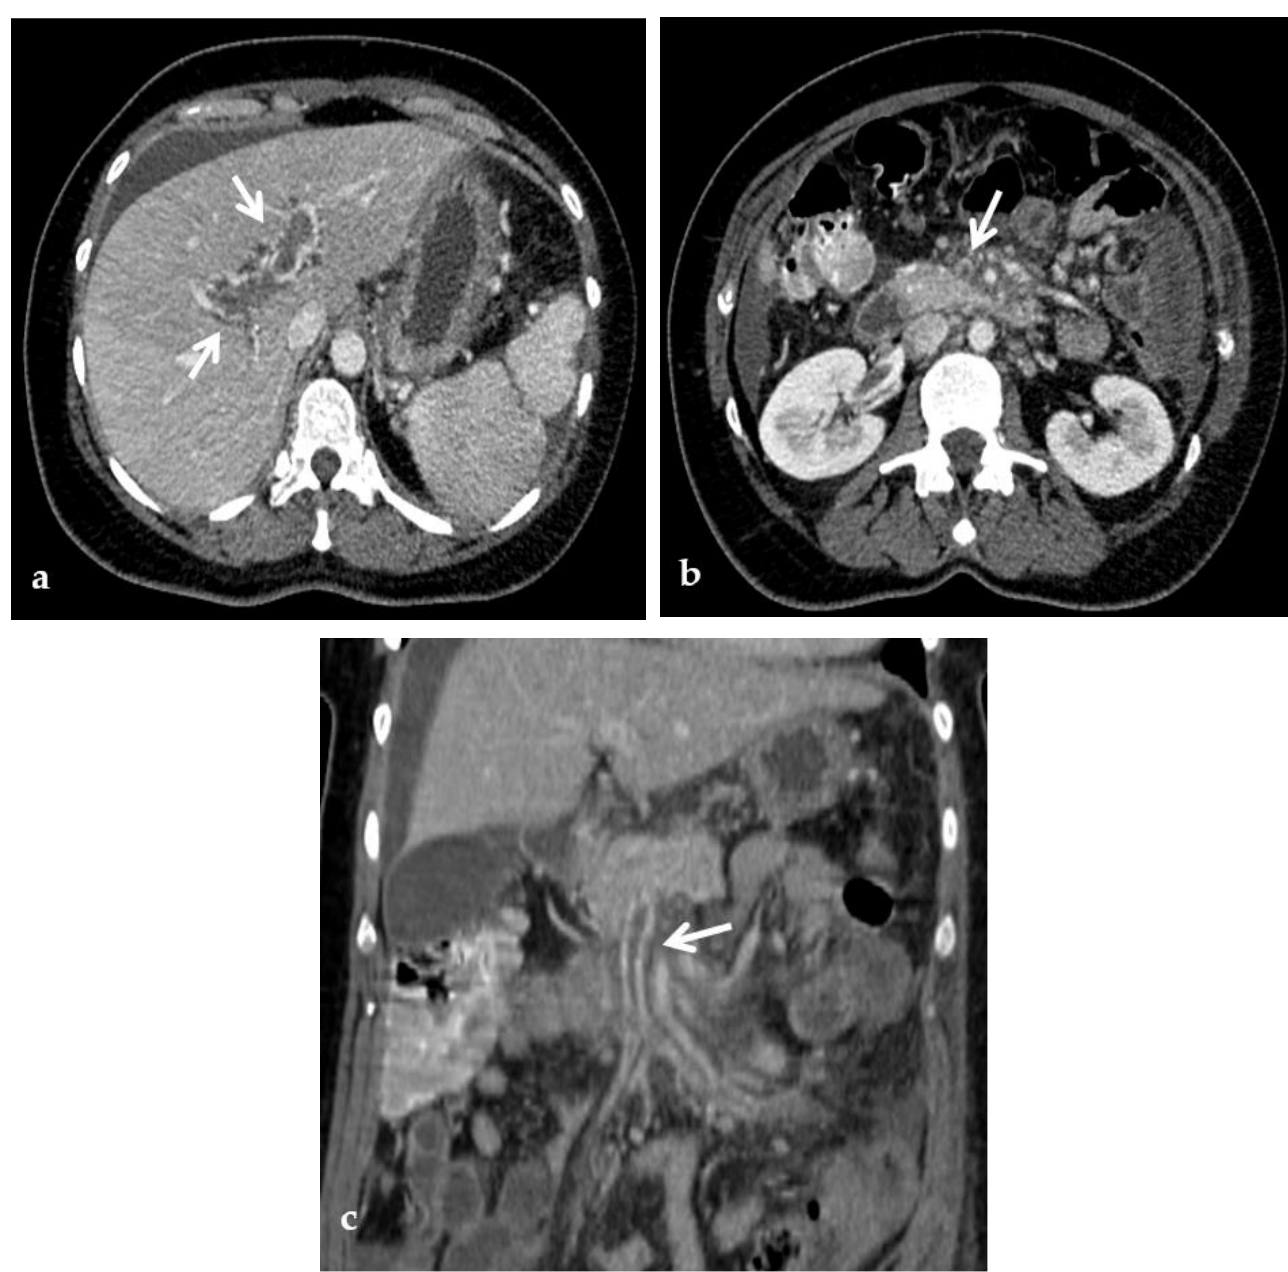
Figure 5. CT of a 21-year-old female who underwent deceased-donor orthotopic liver transplanta- tion (split II-III) for biliary atresia, complicated by the development of portal vein thrombosis and cavernous transformation, who presented with melena and hematemesis 12 years after transplan- tation. ( a ) Arterial phase axial CT images show multiple arterial aneurysms of the diaphragmatic and gastric arteries, with hypertrophic submucosal vessels in the gastric fundus (arrows). ( b ) Arte- rial phase axial CT image also shows multiple large arterial aneurysms of the splenic artery (arrows).